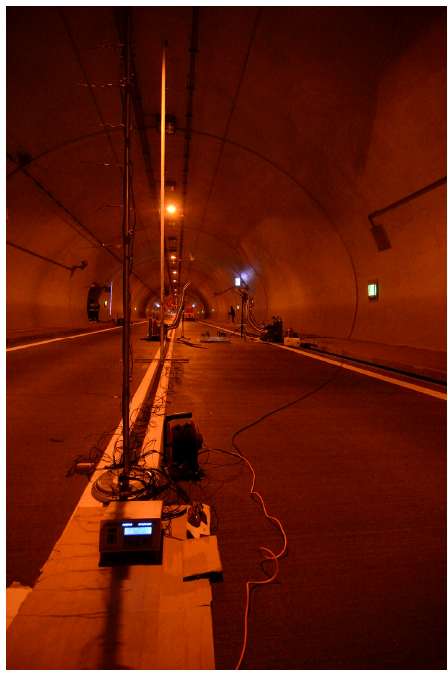
Figure 4. Stand-poles with thermocouples and a thirty-channel thermometer.